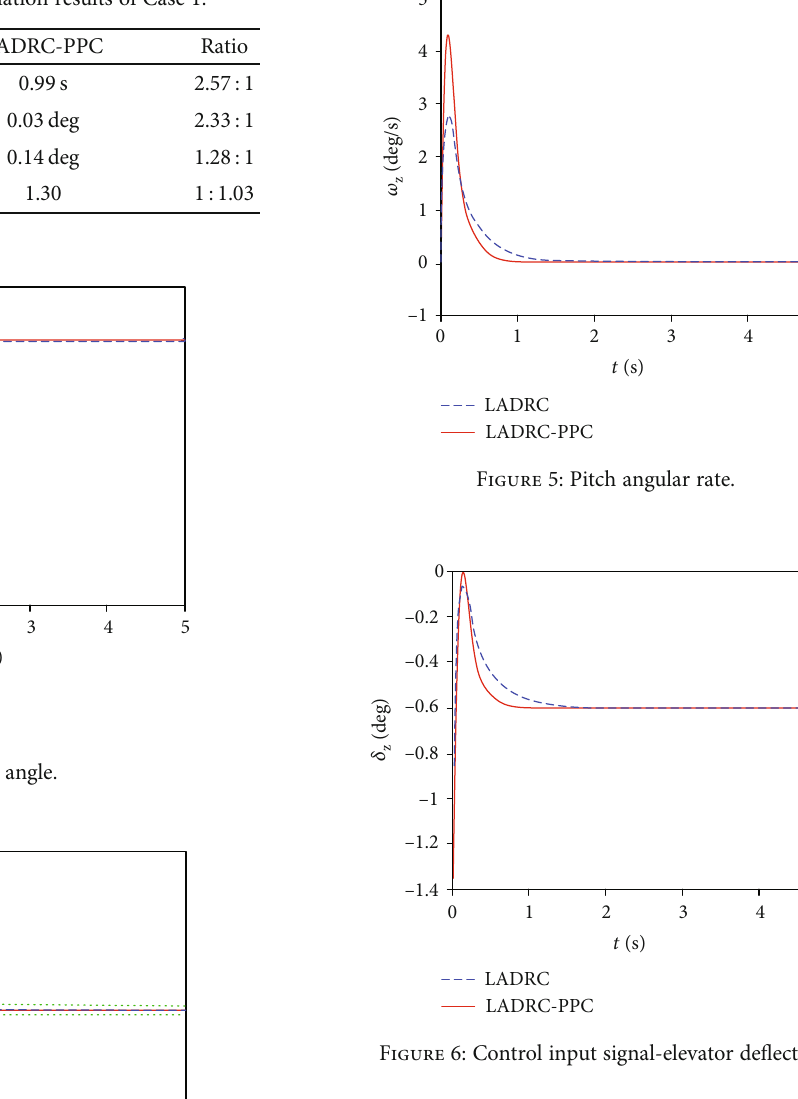
Table 1: The comparative simulation results of Case 1.